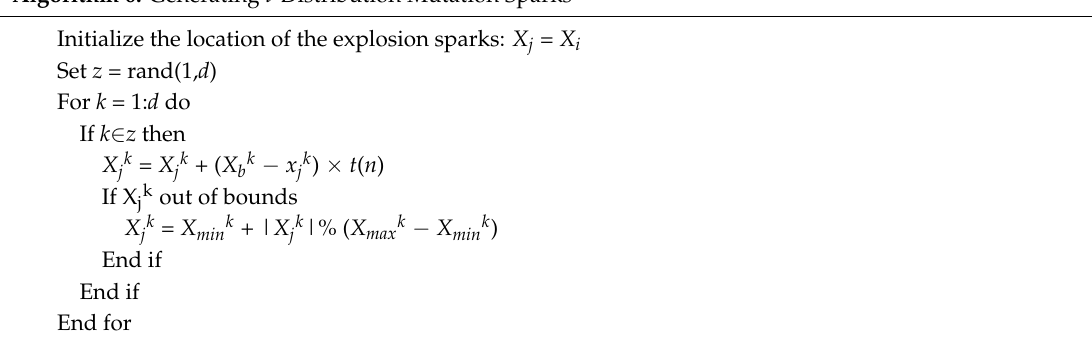
Algorithm 6: Generating t -Distribution Mutation